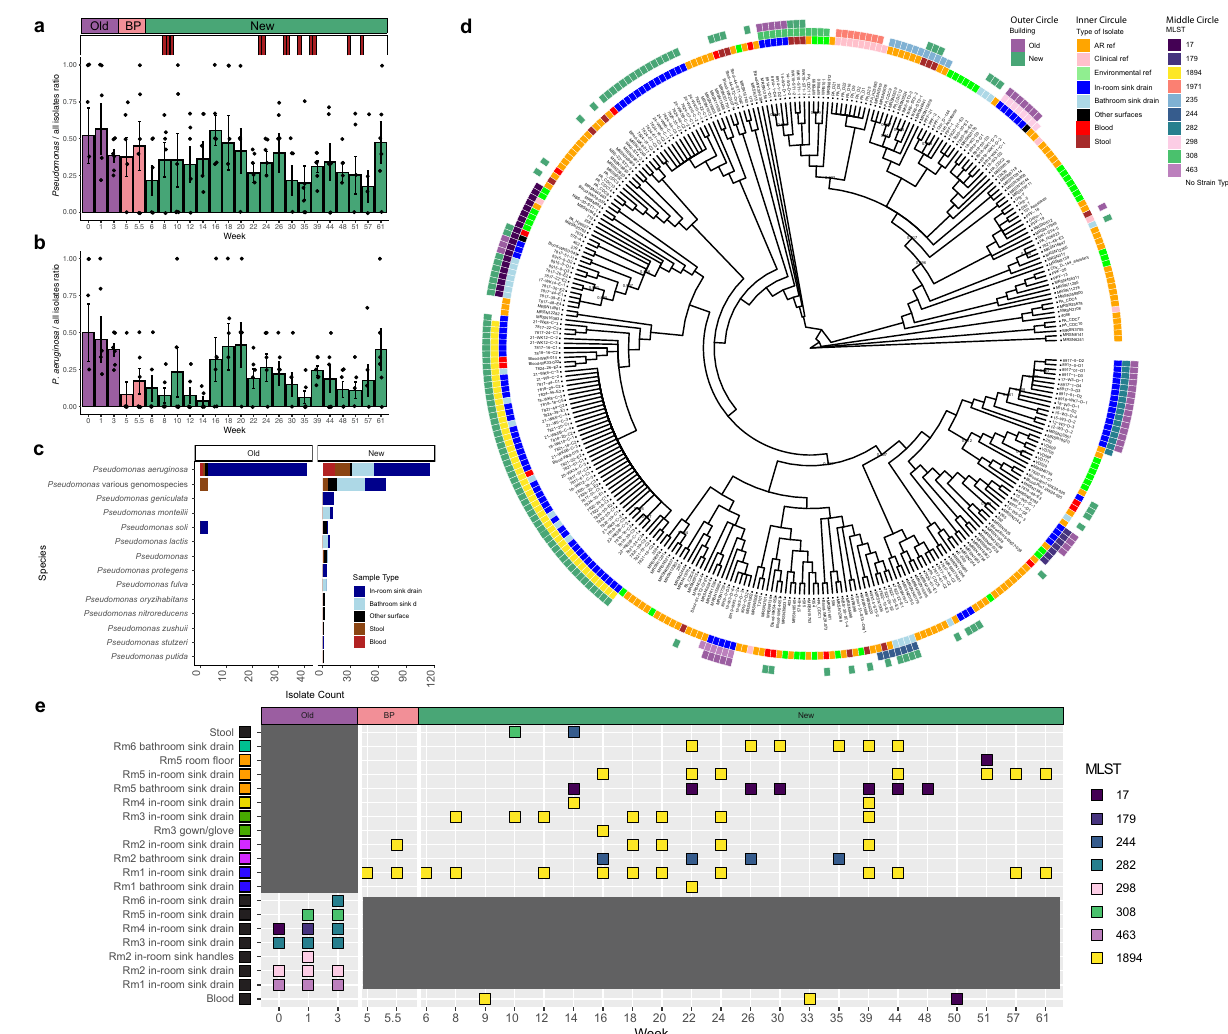
Fig. 4 Timing, identity, and phylogenetics of Pseudomonas spp. isolates. a Ratio of Pseudomonas spp. to all isolates across all time points ( n = 283 Pseudomonas isolates). Error bars indicate standard error. Red bars indicate collection timing of Pseudomonas aeruginosa blood culture isolates. b Ratio of P. aeruginosa to all isolates across all time points ( n = 155 P. aeruginosa isolates). Error bars indicate standard error. c Identity of all collected Pseudomonas spp. genomes by >95% ANI to reference genome by sample collection type. Other indicates all other surface/water genomes apart from in-room and bathroom sink drain. All genomes were identi fi ed as Pseudomonas spp. by MASH. Pseudomonas various genomospecies includes all different genomospecies that did not share >95% ANI with a reference genome. d Cladogram from a core genome alignment of P. aeruginosa genomes. Branches with less than 80% bootstrap support are collapsed. Branches with bootstrap values between 80 – 95% are labeled. Reference P. aeruginosa genomes included antibiotic- resistant (AR) isolates, clinical isolates, and environmental isolates. Reference MLST is included if it shares a MLST with collected isolates. e Time point mapping of top 8 MLST P. aeruginosa groups by sample collection location. BP before patient and staff